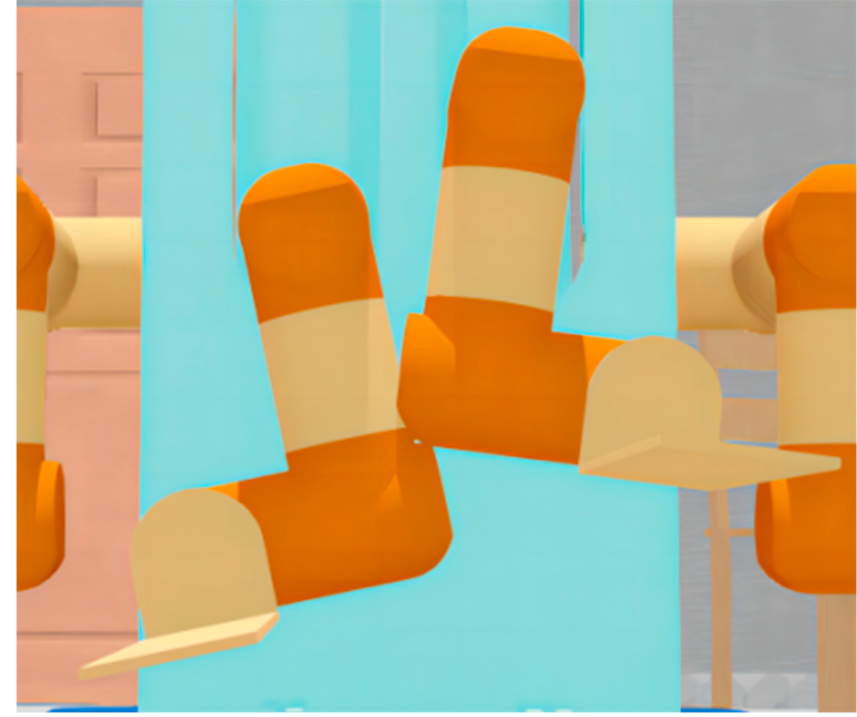
Figure 10. Dual-manipulator LF-RF with self-collision.